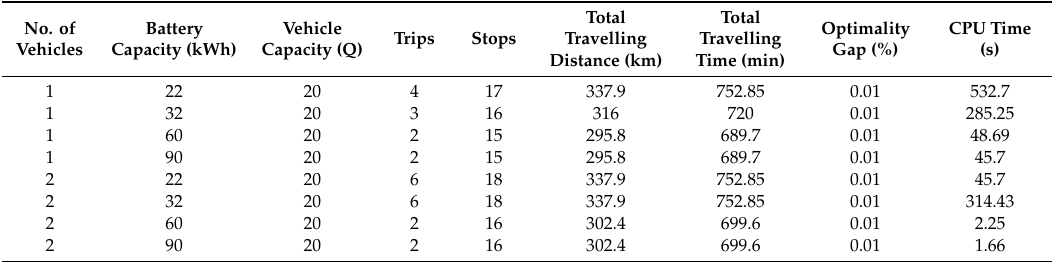
Table 13. The optimal solutions under di ff erent Battery capacities of the BEV ( q k